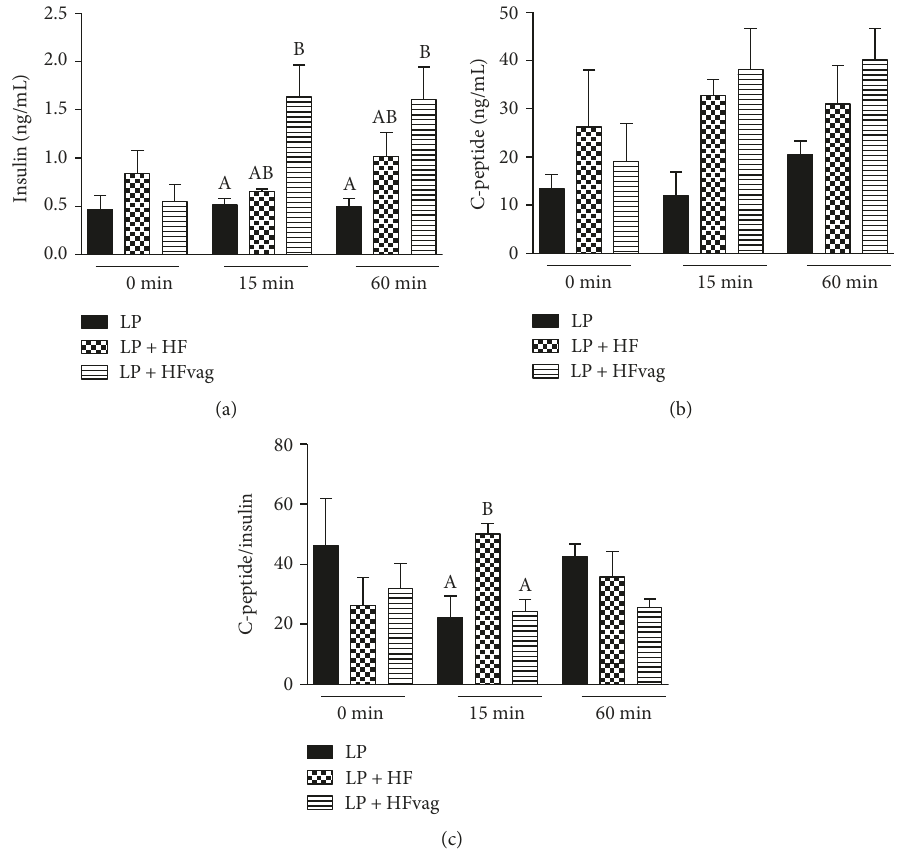
Figure 3: Vagotomy reduced insulin clearance. Plasma concentration of insulin (a), C-peptide (b), and C-peptide :insulin ratio (c) at 0, 15, and 60min during ipGTT. Data are means ± SEM from the LP ( n = 3 – 6 ); LP +HF ( n = 3 – 5 ); and LP + HFvag ( n = 4 – 6 ). Di ff erent letters over the bars indicate signi fi cant di ff erences. One-way ANOVA followed by Tukey ’ s test. P < 0 05